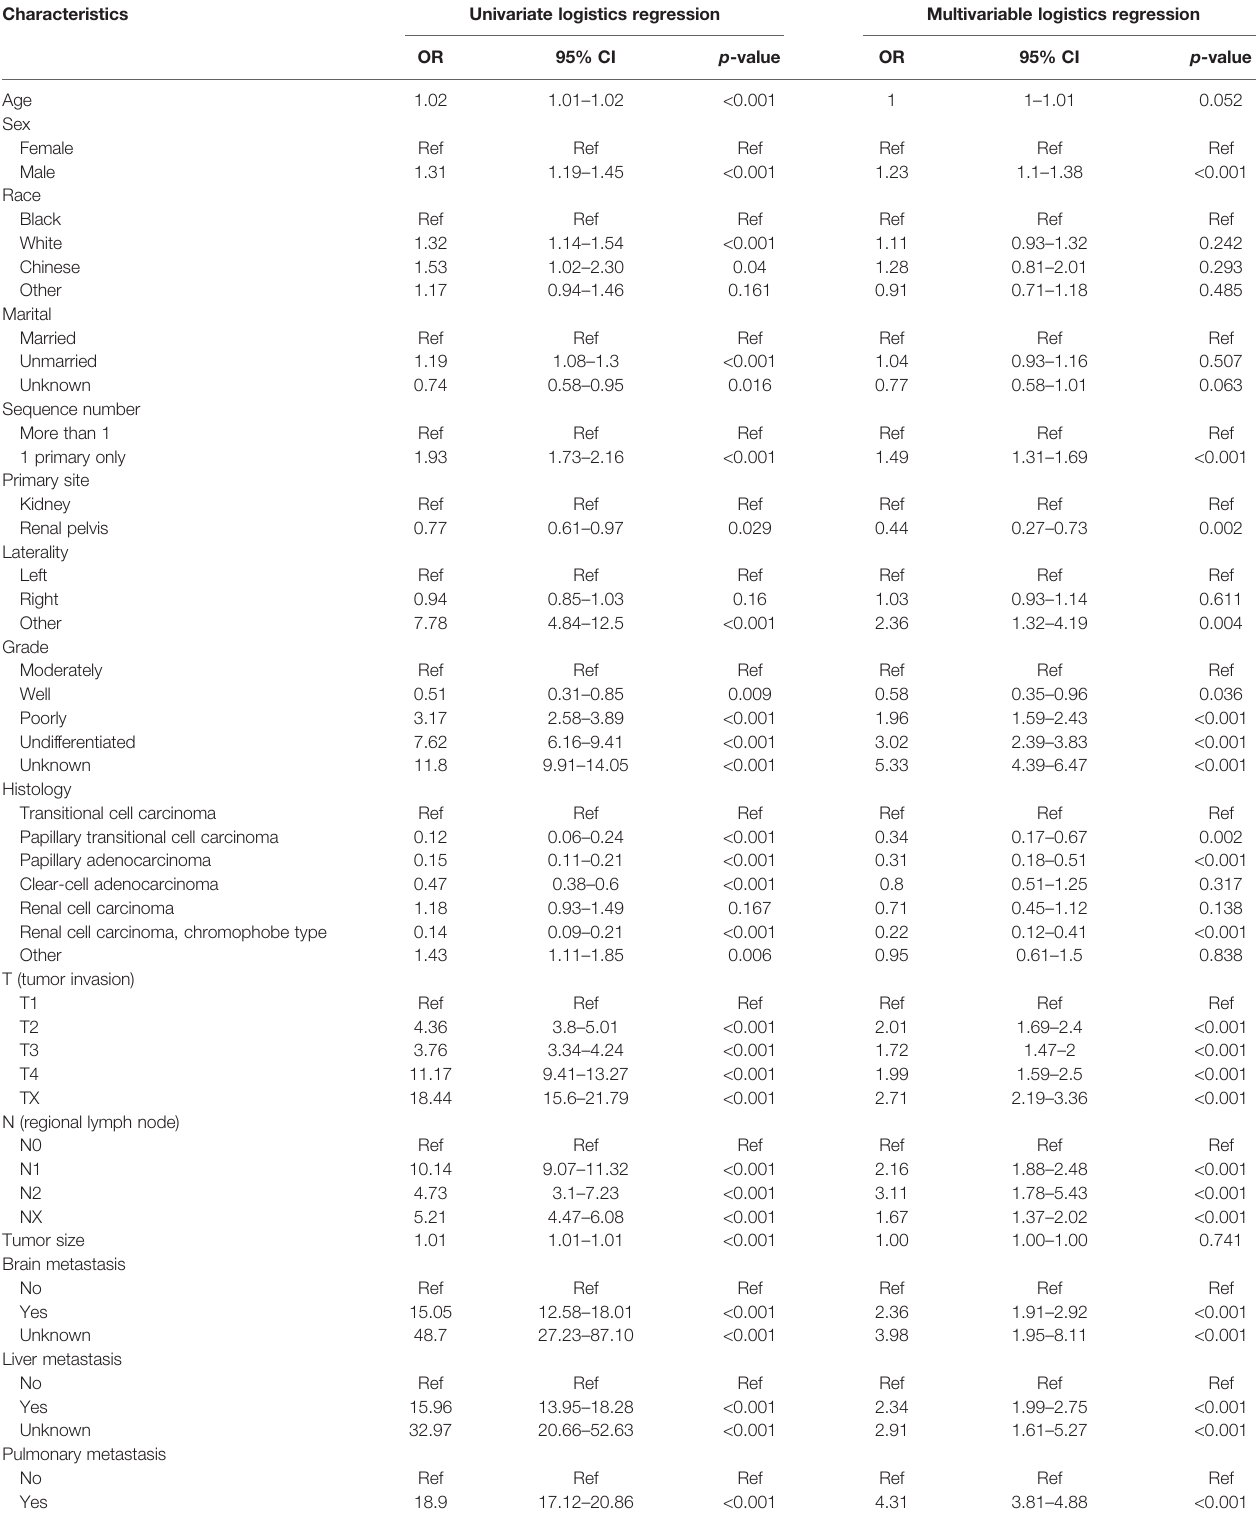
TABLE 3 | Relationship between variables and BMs by univariate and multivariate logistic regression